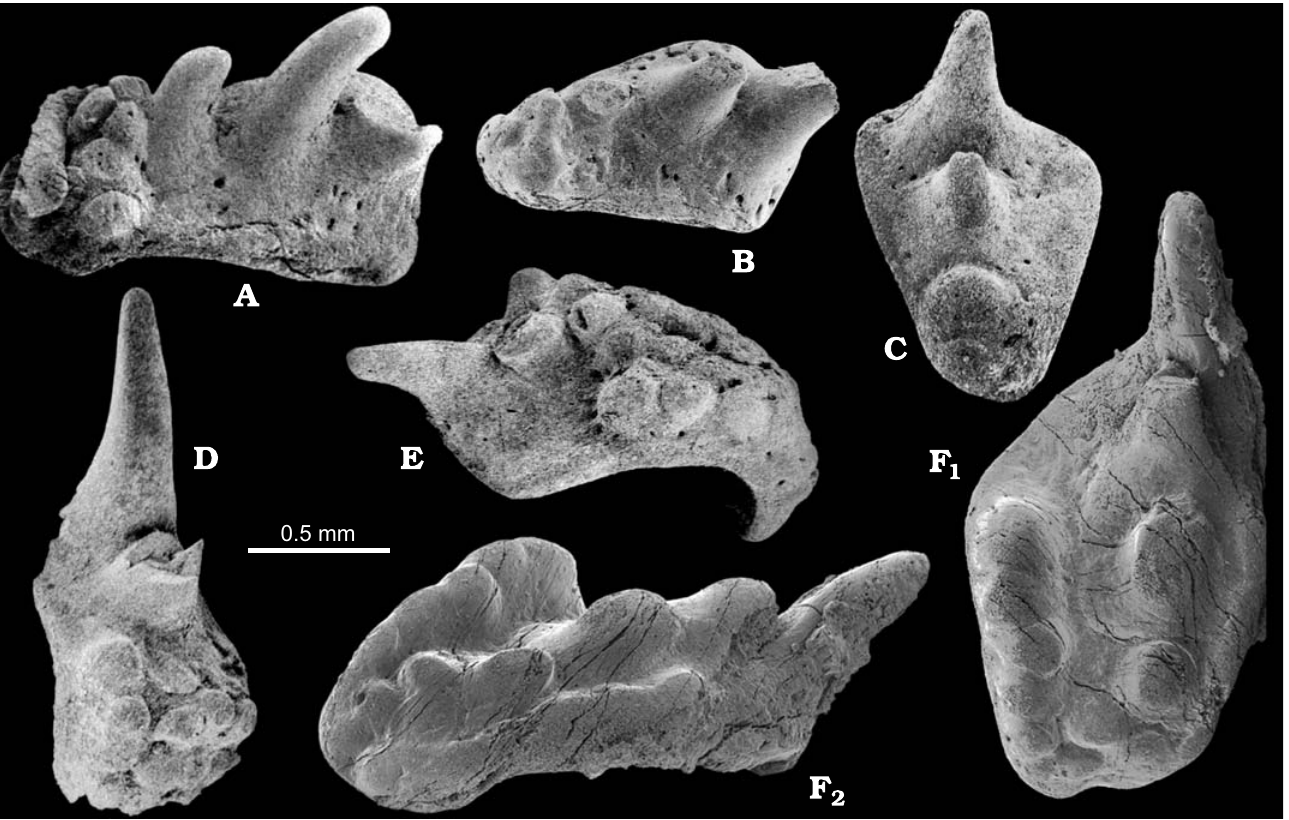
Fig. 12. SEM micrographs of ?ischnacanthiform tooth whorls from early Frasnian, horizon GI4 of an unnamed formation in the Chahriseh section, Kaftari Mt., central Iran. A . AEU 314 in occluso−lateral view. B . AEU 315 in occluso−lateral view. C . AEU 316 in occlusal view. D . AEU 317 in occlusal view. E . AEU 318 in occluso−lateral view. F . AEU 319 in occlusal (F 1 ) and in occluso−lateral (F 2 ) views. A, B, and F 2 anterior to the left, C, D, and F 1 anterior to the page bottom, and E anterior to the